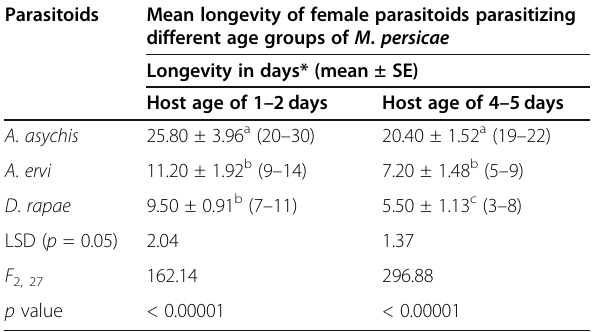
Table 5 Mean longevity (mean ± S.E.) of A . asychis , A . ervi , and